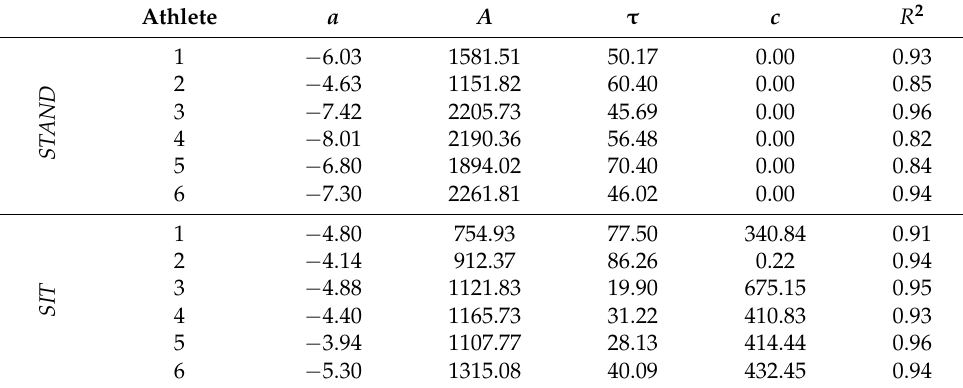
Table 1. Parameters of the physiological model with their coefficient of determination for the initial standing ( STAND ) and the following phase ridden in a seated position ( SIT ) ( n = 6).